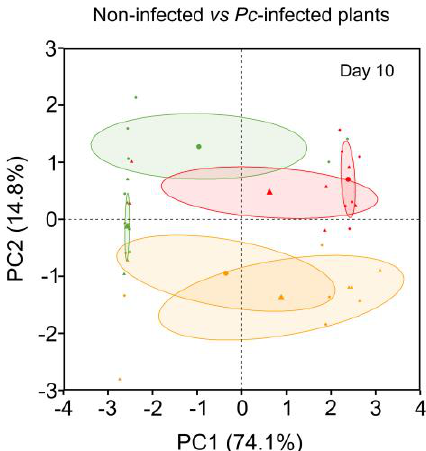
Figure 7. PCA of phenolic compounds included in Table 4 of non-infected Castanea sativa seedlings exposed to ambient temperature (green circles), high ambient temperature (orange circles) and two heat waves (red circles) (non-infected plants) and Phytophthora cinnamomi -infected C. sativa seedlings previously exposed to ambient temperature (green triangles), high ambient temperature (orange triangles) and two heat waves (red triangles) ( Pc -infected plants). The five compounds that most contributed to the PC1 and PC2 axes were leaf 3-feruloylquinic acid (81.3%), root 4-hydroxyphenylacetic acid (8.7%), root coniferyl aldehyde (3.9%), root hydroxybenzoic acid (3.6%) and leaf ellagic acid (0.9%).